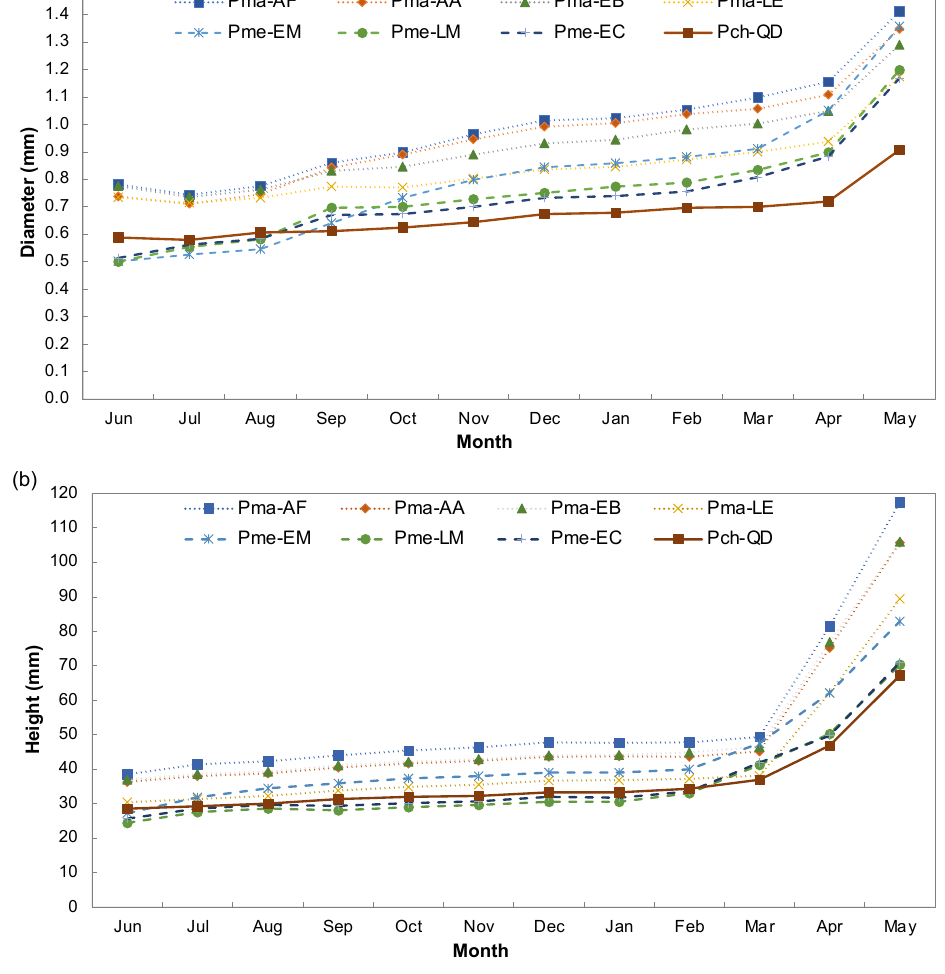
Figure 2. Monthly measurements of diameter ( a ) and height ( b ) growth traits of provenances of three Mexican spruces (June 2019—May 2020). Picea chihuahuana —only one provenance, Quebrada de los Dur á n (Pch-QD). Picea martinezii (Pma)—four provenances: Agua Fr í a (Pma-AF), Agua Alard í n (Pma- AA), El Butano (Pma-EB) and La Encantada (Pma-LE). Picea mexicana (Pme)—three provenances: El Mohinora (Pme-EM), La Marta (Pme-LM) and El Coahuil ó n